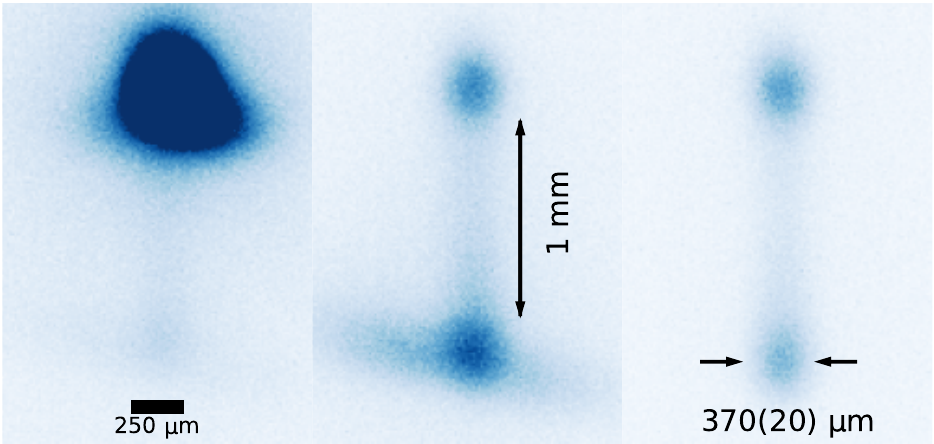
Figure 5. Double cloud structure. Three stages of experiment are shown from left to right: 2nd-stage MOT, intermediate process of recapturing into 3rd-stage MOT, two clouds in optical lattice without any MOT radiation and magnetic